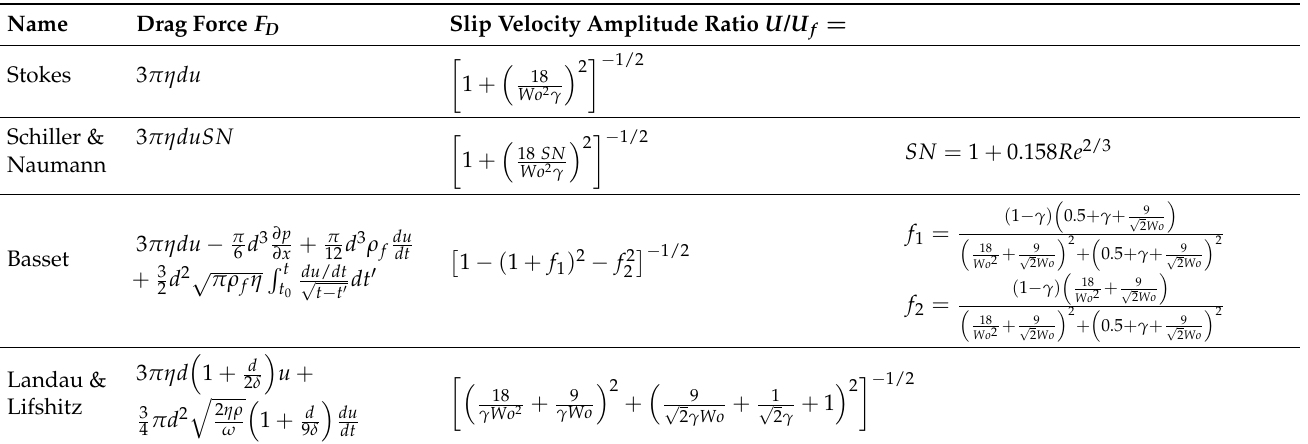
Table 1. Amplitude ratio of slip to fluid velocity U / U f for several drag models dependent on the Womersley number Wo 2 and the density ratio γ